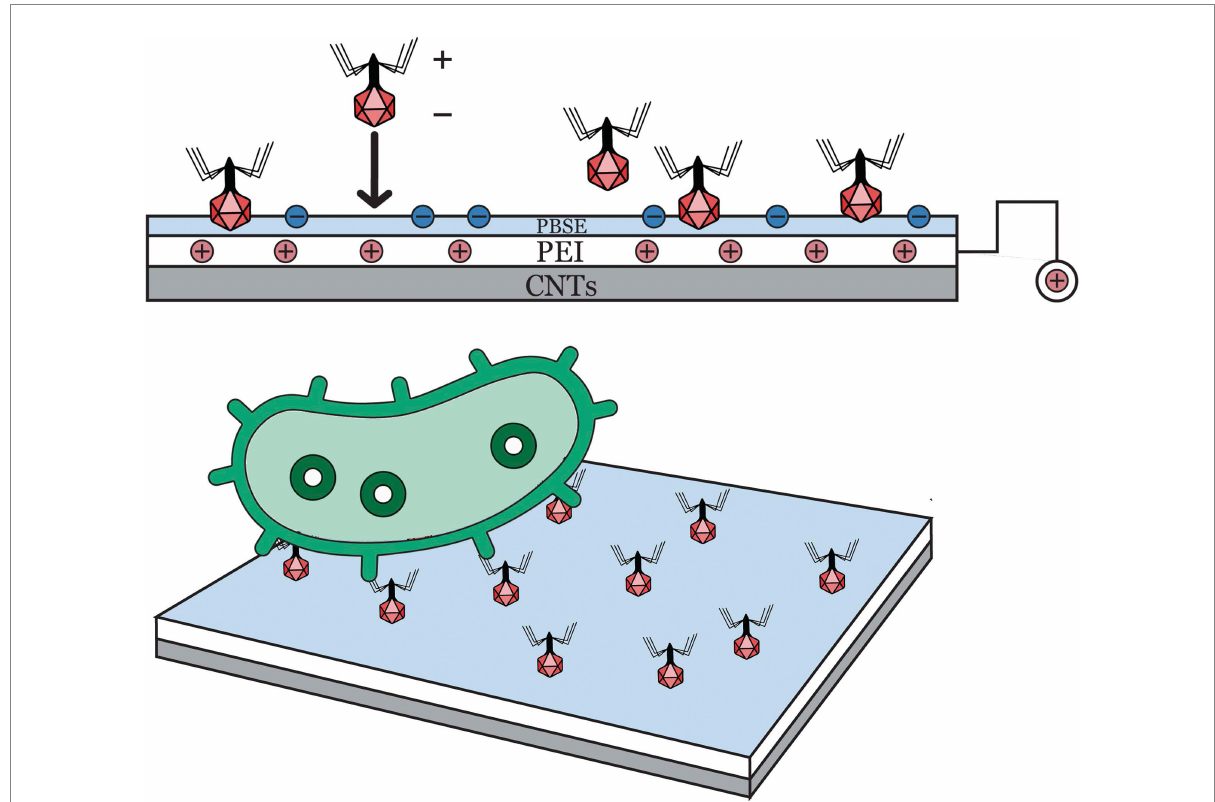
FIGURE 4 A new impedimetric biosensing based on carbon nanotube (CNT) with T2 bacteriophages for detection of E. coli B (Zhou et al.,